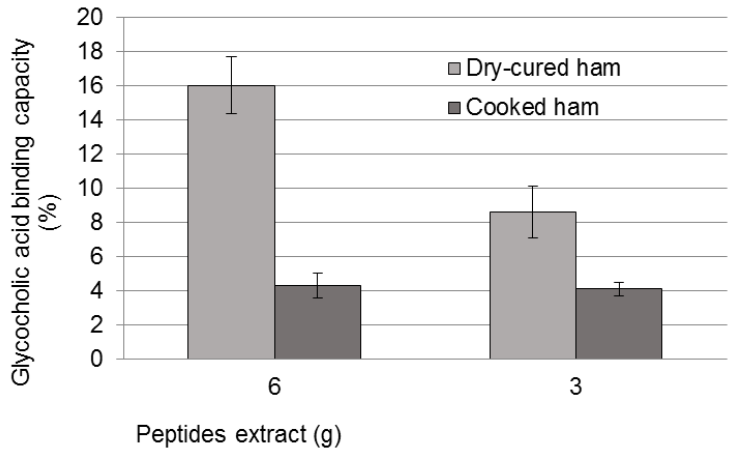
Figure 1. Sequestering capacity of bile acids measured in glycocholic acid presence for the two meat products.